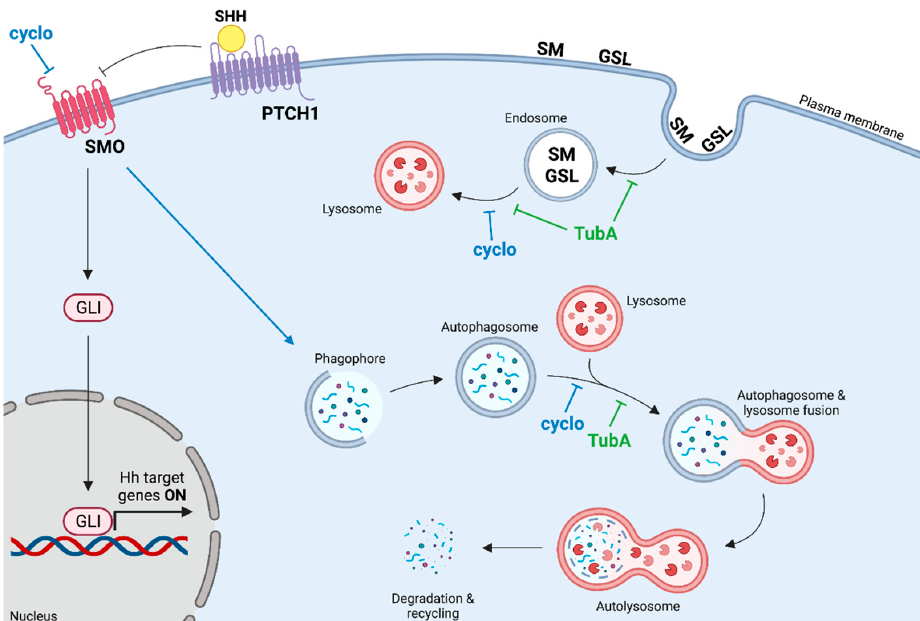
Figure 7. Mechanism of action of TubA and cyclo. The path of cyclo is indicated in blue while that of TubA is indicated in green. cyclo: cyclopamine; TubA: tubastatin A. SMO: smoothened; PTCH1: Ptached1; GLI: glioma-associated oncogene. SM: sphingomyelin, GSL: glycosphingolipid. Image generated with the BioRender.com